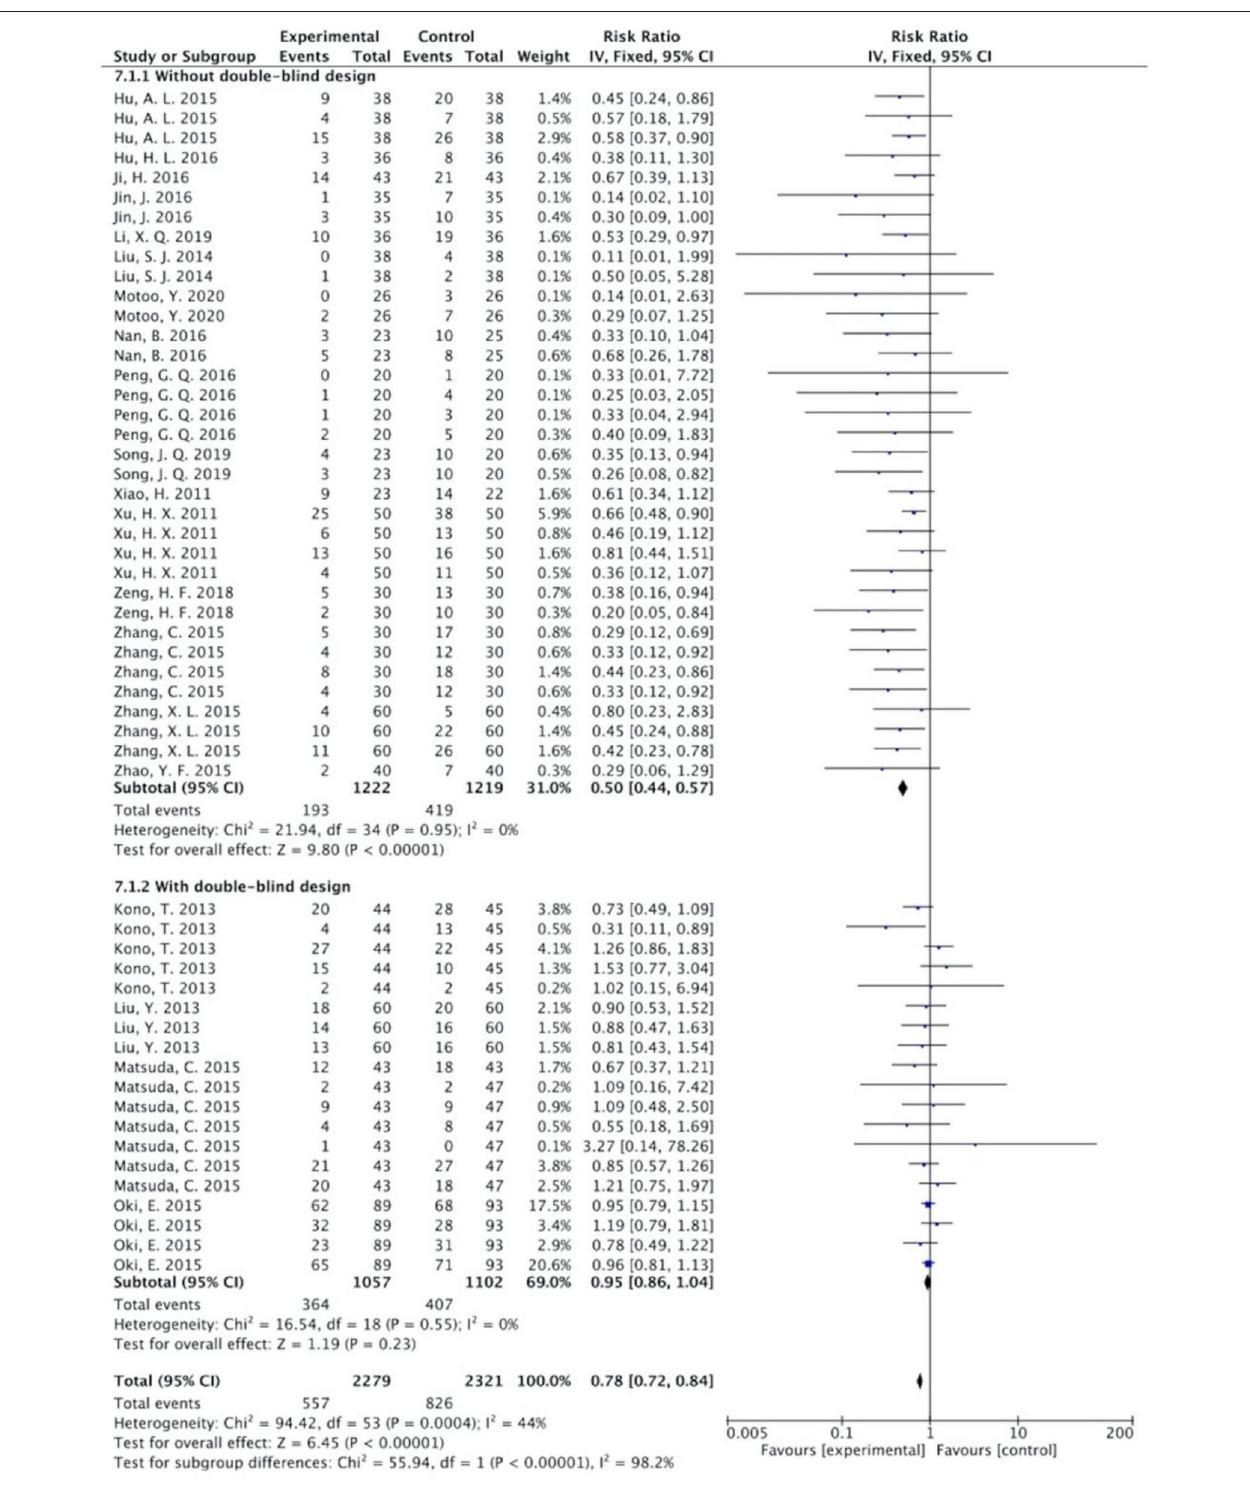
FIGURE 4 | Overall effect of herbal medicine on chemotherapy-induced gastrointestinal toxicity reported as risk ratio.